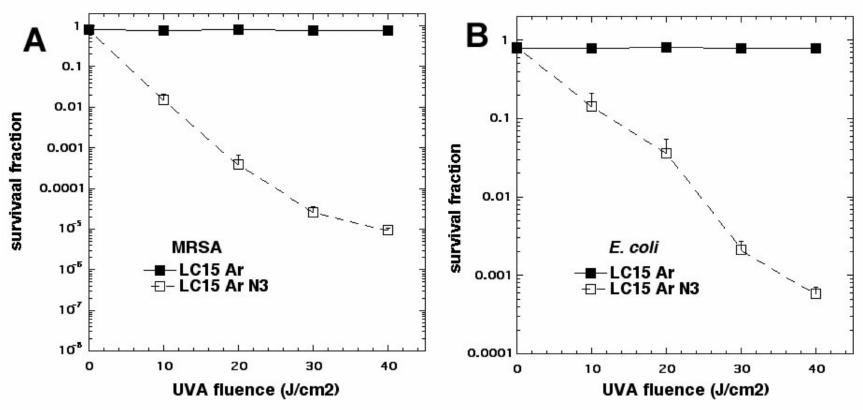
Figure 6. Oxygen-independent (under argon) LC15 fullerene photoinactivation by addition of sodium azide. ( A ) methicillin resistant S. aureus (MRSA); ( B ) E. coli. Figure adapted from data contained in